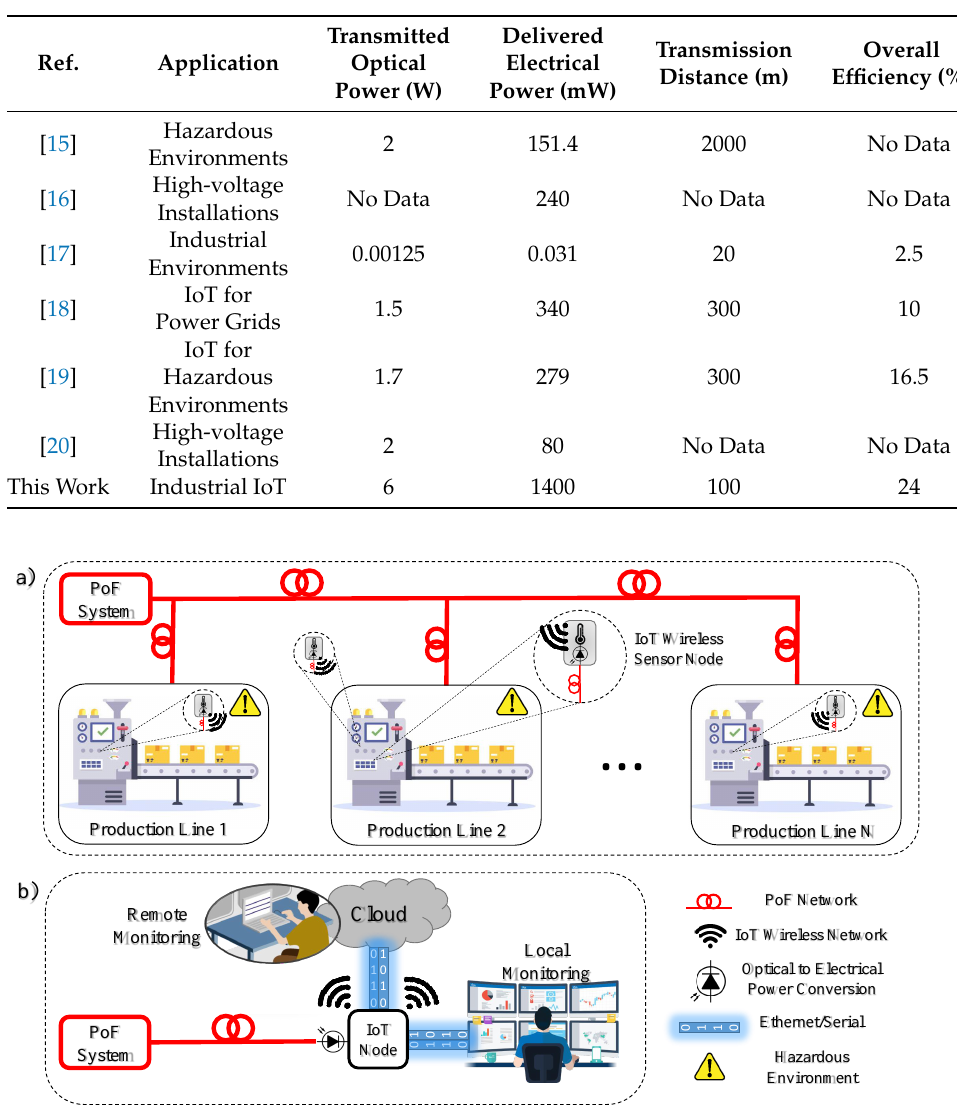
Table 1. Main parameters of the PoF state-of-the-art solutions for sensing applications.